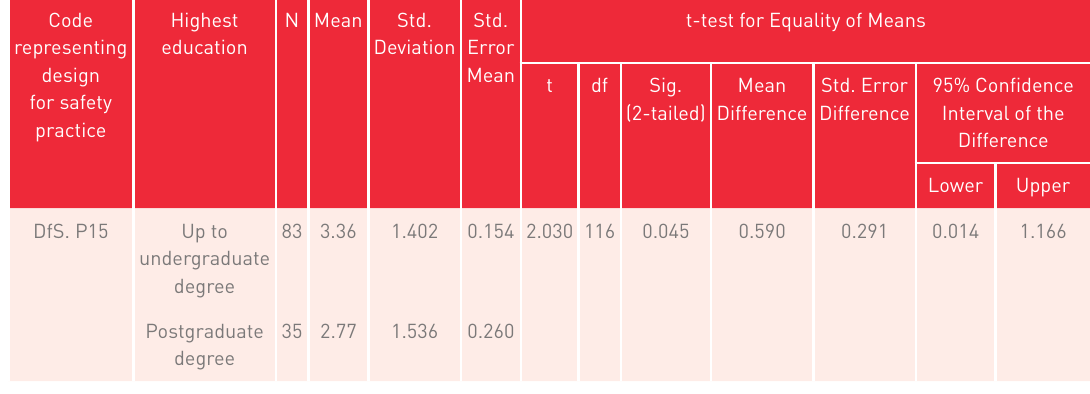
Table 11. Independent samples t-test based on the highest level of